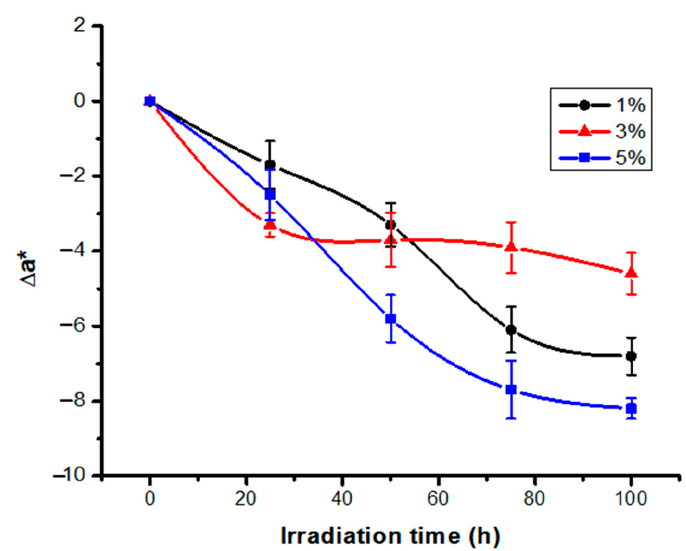
Figure 1. Δ L* variation recorded for RB_204 samples during irradiation. The values of the parameter a* gradually decrease with the irradiation time regardless of the concentration of the RB_204 solution used for dyeing, as it may be seen in Table 2. The negative values of the ∆ a* differences presented both in Table 2 and in Figure 2 confirm that during irradiation, the dyed fabric loses its red component.